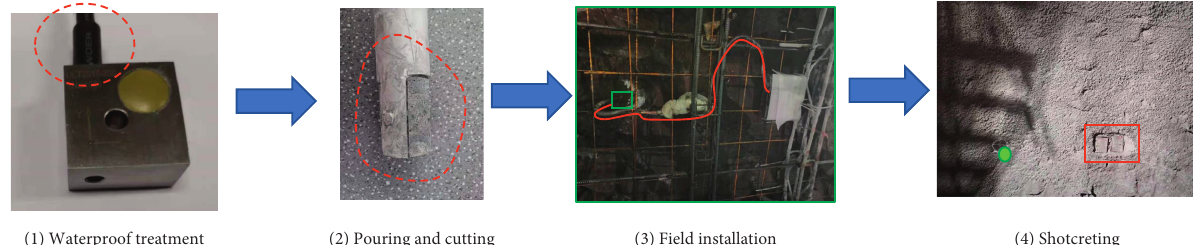
Figure 4: Sensor installation